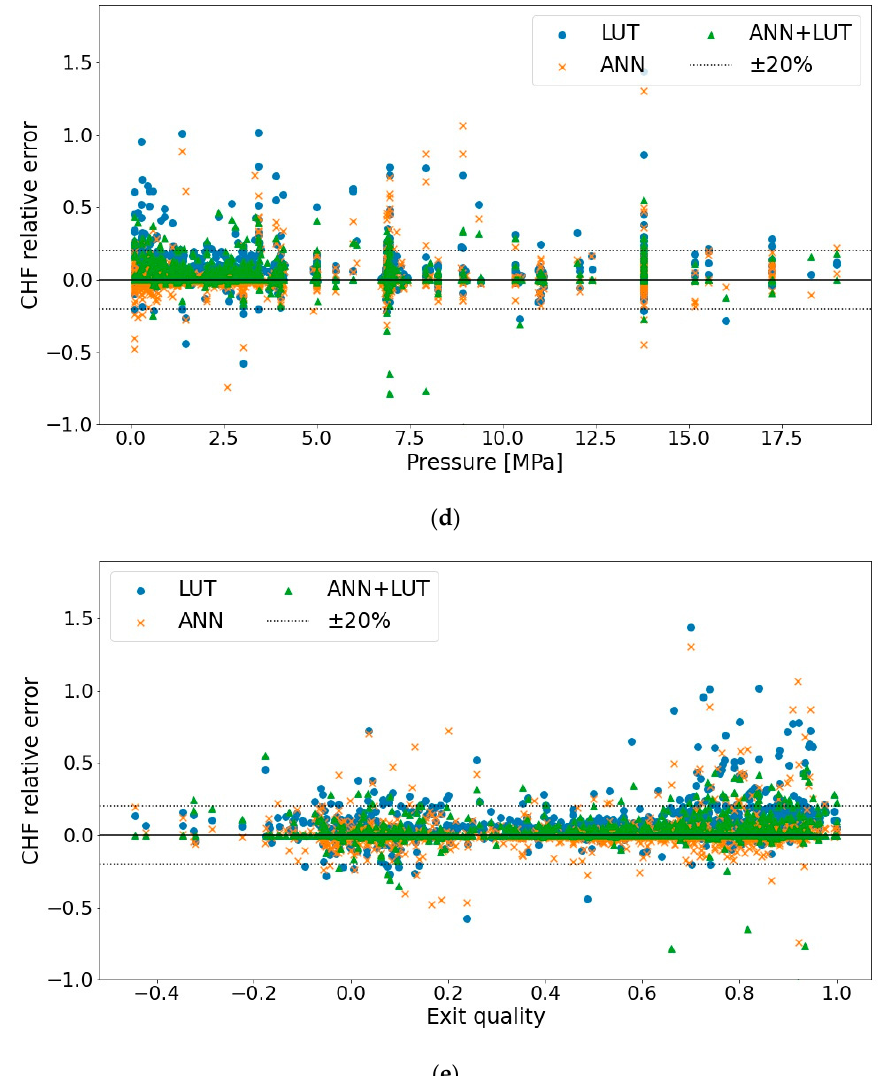
Figure 10. CHF relative error distribution vs. tube diameter ( a ), heated length ( b ), mass flowrate ( c ), pressure ( d ), exit quality ( e ) .